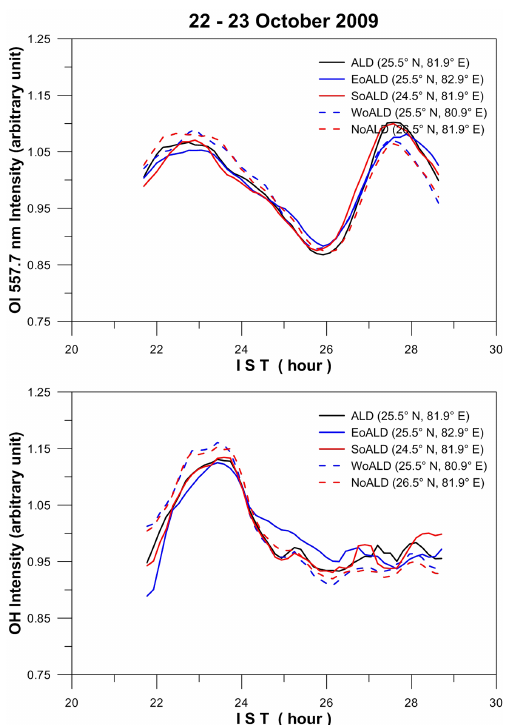
Figure 2. Nocturnal variation of OH broadband and OI 557.7nm emission intensity at different sampling positions over Allahabad on 22–23 October